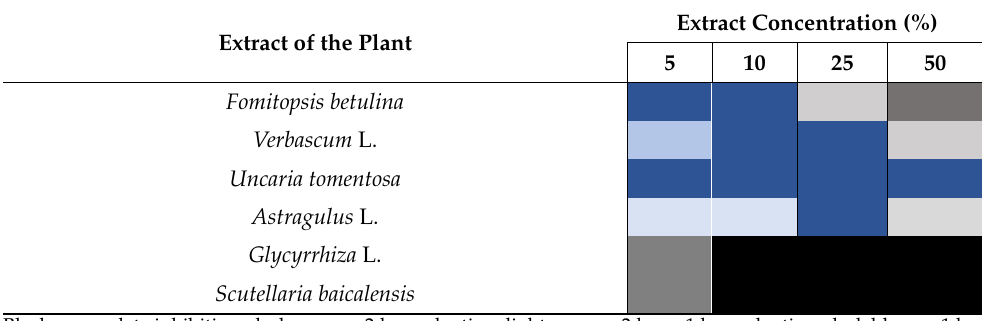
Extract Concentration (%) 5 10 25 50